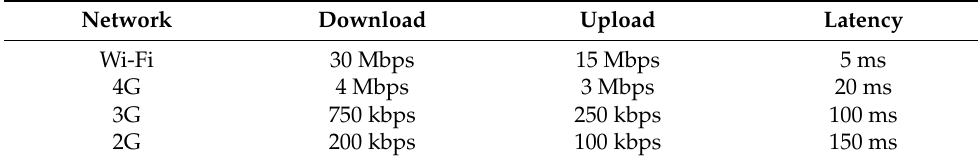
Figure 6. FPS comparison of three platforms based on image size and the number of people. Table 6. Internet profiles, based on several network technologies.